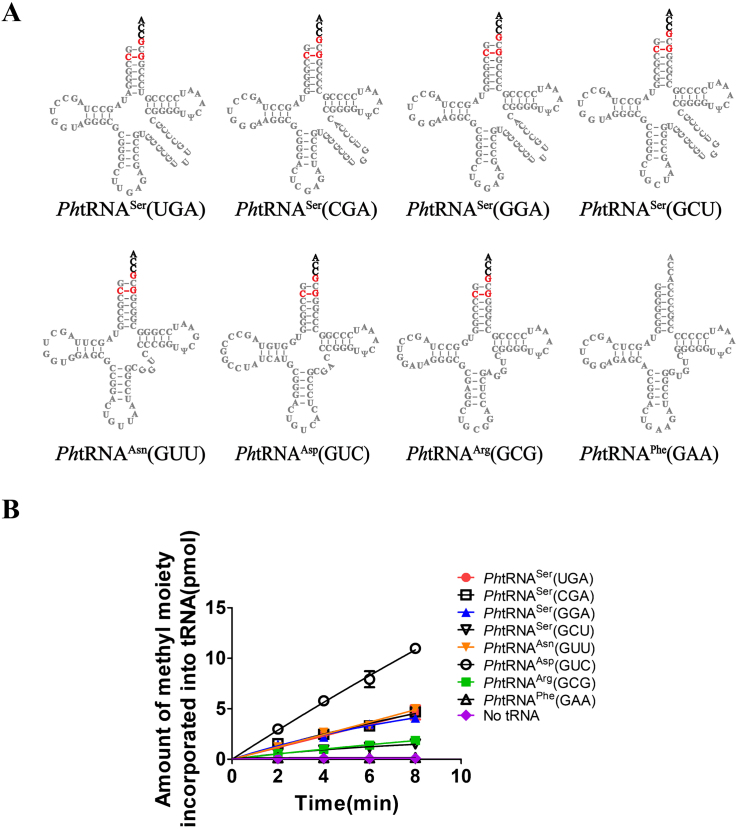

PhNSun6 has wide-range of tRNA substrates. The secondary structures (A) and the methylation capacity by PhNSun6 (B) of PhtRNASer(UGA), -(CGA), -(GGA) and -(GCU), PhtRNAAsn(GUU), PhtRNAAsp(GUC), PhtRNAArg(GCG) and PhtRNAPhe(GAA).